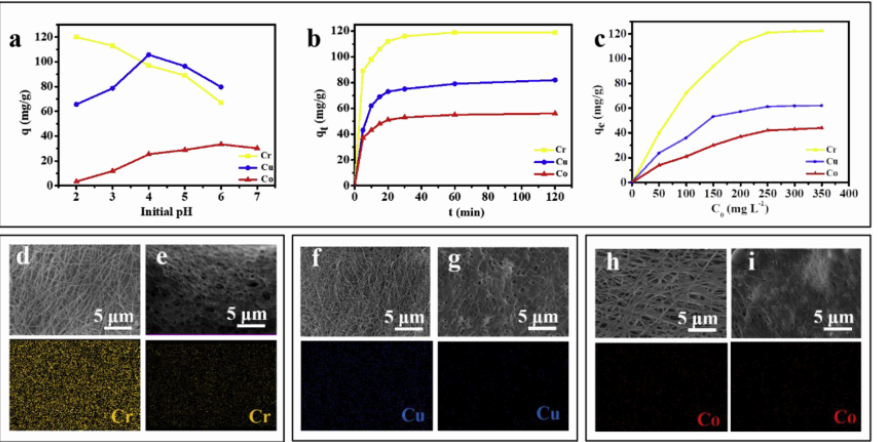
Figure 6. Effect of different factors on heavy metal adsorption, ( a ) pH of solution; ( b ) contact time and ( c ) initial concentrations. SEM pictures and element mapping of CS of CS-PGMA-PEI-ENMs for adsorption and desorption of Cr(VI) ( d , e ). Cu(II) ( f , g ). Co(II) ( h , i ). ( a : 300 mg/L, t = 5 h, m = 100 mg, V = 100 mL, T = 25 °C; b : C = 300 mg L, initial pH = 2.0 (Cr 0 0 (VI)), 4.0 (Cu(II)), 6.0 (Co(II)), m = 100 mg, V = 100 mL, T = 25 °C; c: initial pH = 2.0 (Cr(VI)), 4.0 (Cu(II)), 6.0 (Co(II)), t = 1 h, m = 100 mg, V = 100 mL, T = 25 °C) Adapted with permission from ref. [115]. Copyright 2021 Elsevier.